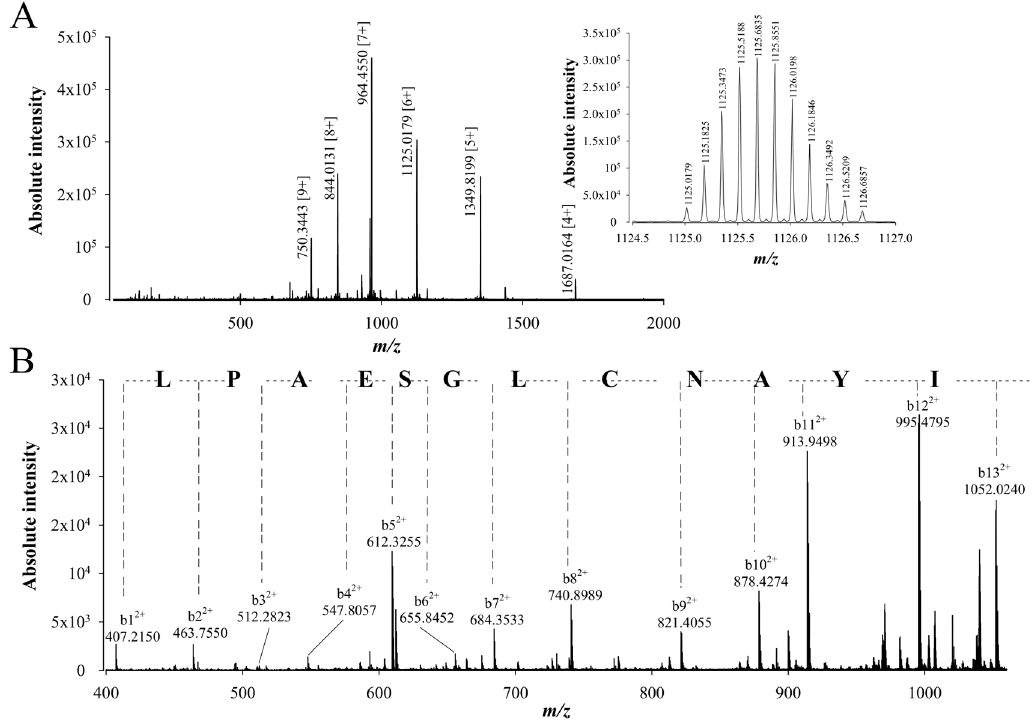
Figure 6. De novo sequencing of compound 1 from fraction F11 by LC-ESI-QTOF MS / MS after reduction and alkylation (top-down approach). ( A ) LC-ESI-QTOF MS of the reduced and alkylated compound 1 from F11. Inset: LC-ESI-QTOF MS of m / z 1125.0179 [6 + ]. ( B ) LC-ESI-QTOF MS / MS of precursor ion m / z 1125.0179 [6 + ]. The resulting peptide sequence is LPAESGLCNAYI. Peaks corresponding to the b ions from this peptide are annotated on the spectrum.